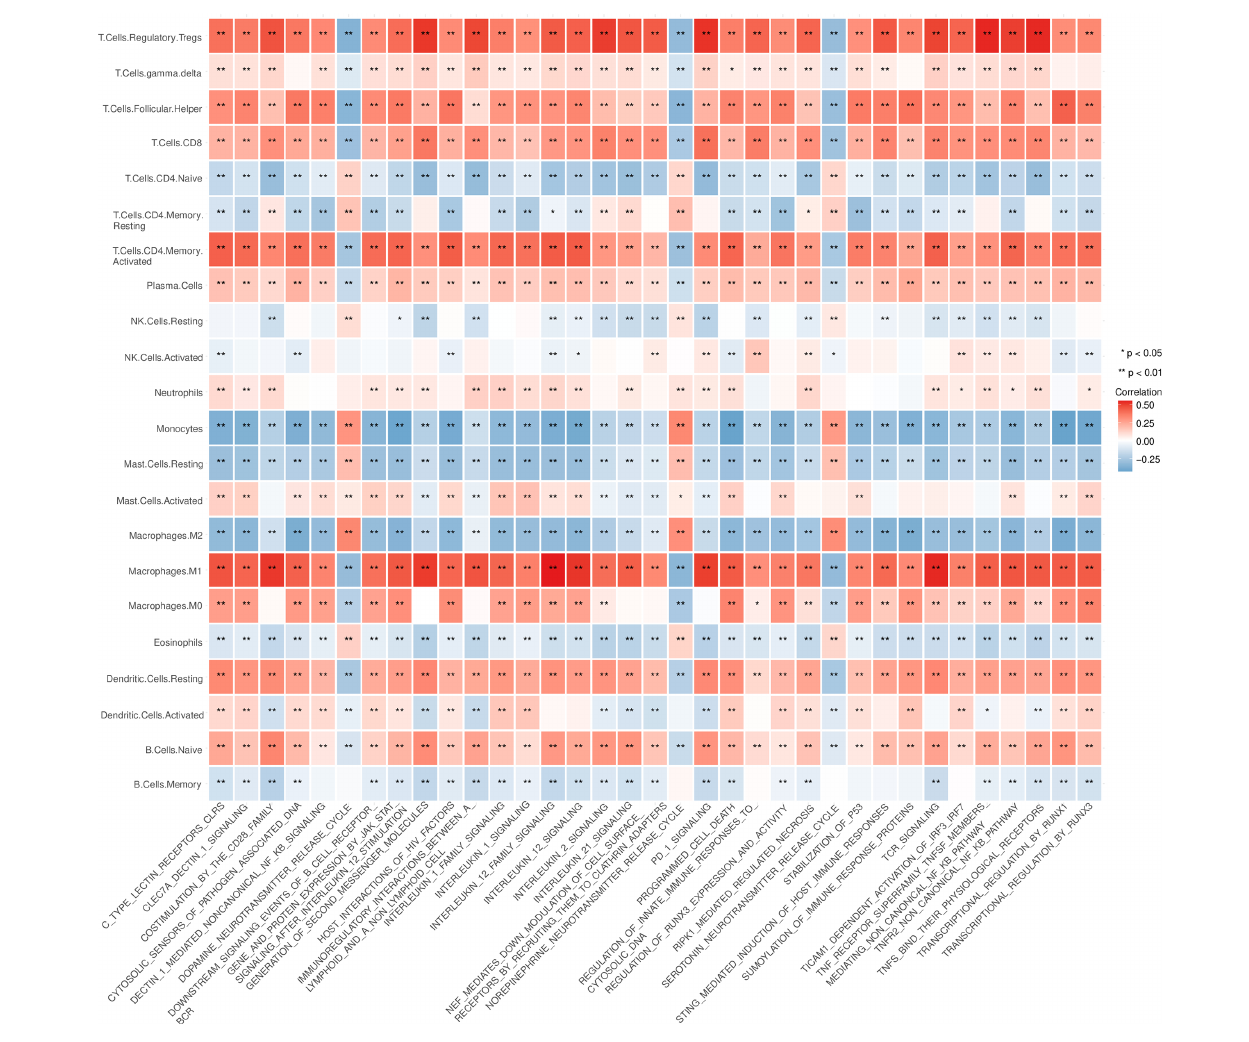
FIGURE 6 | 4Analysis of the correlation between the in fi ltration score of immune cells and the pathway enrichment score of the gene set variation analysis (GSVA). *P < 0.05, **P <